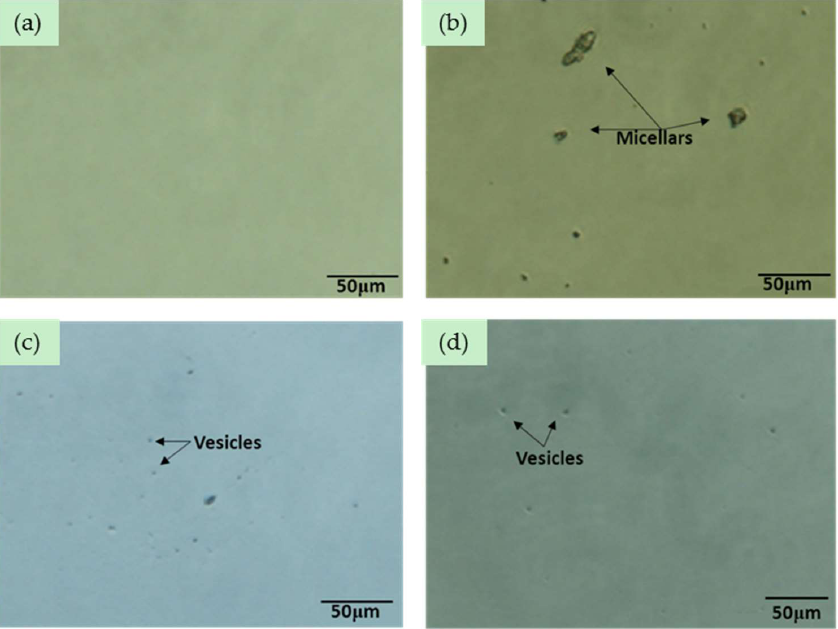
Figure 7. Particle size distribution of HSYA samples (1, XBJ injection; 2, XBJ in aqueous solution; 3, XBJ in buffer solution; 4, buffer; 5, HSYA in aqueous solution; 6, HSYA in buffer solution).